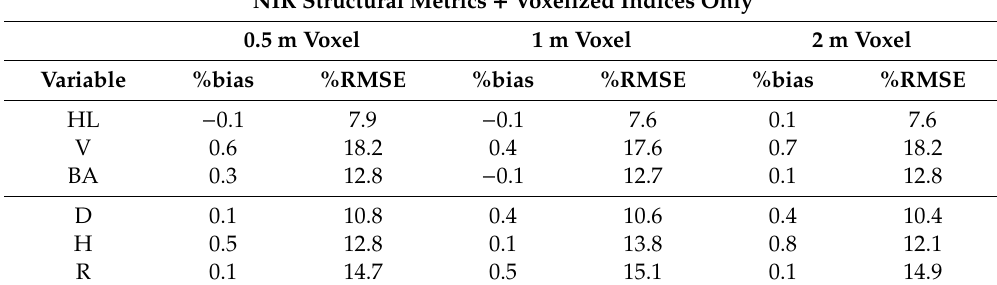
Table 11. %RMSE and %bias results for models trained using voxel vegetation indices at 0.5, 1, and 2 m resolutions and NIR structural